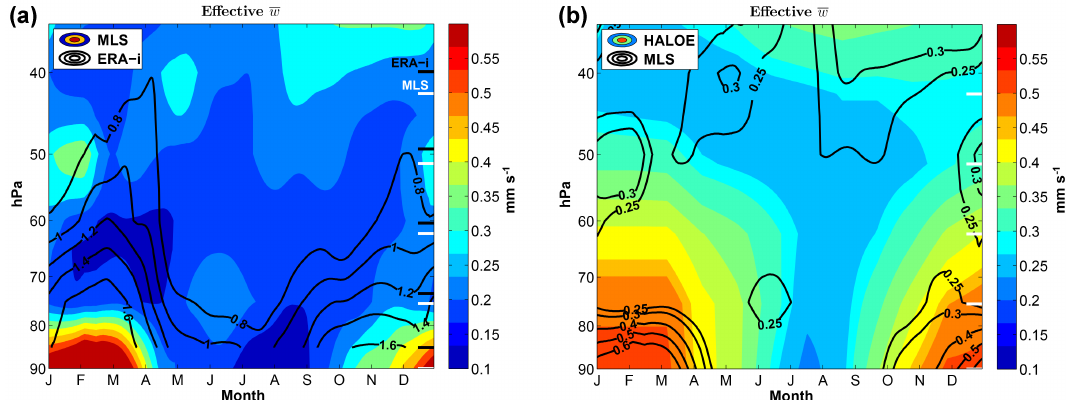
Figure 3. The effective vertical log–pressure transport velocities (mms − 1 ; converted from pressure velocities by multiplying by − H/p ; with H = 7km) based on the phase-lagged correlation method (see text). (a) The MLS observations (colors) vs. the ERA-i reanalysis (black contours; note the different magnitude). (b) HALOE (colors) vs. MLS (black contours, same as the colors on the left). The midpoint levels used for lag correlations are indicated as white (MLS, HALOE) and black (ERA-i) bars on the right of each